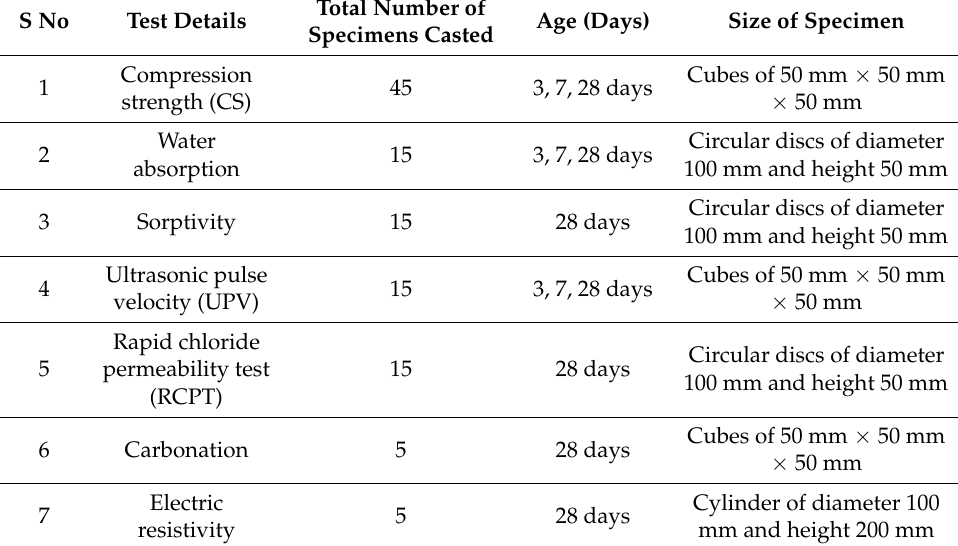
Table 1. Details of experimentation.